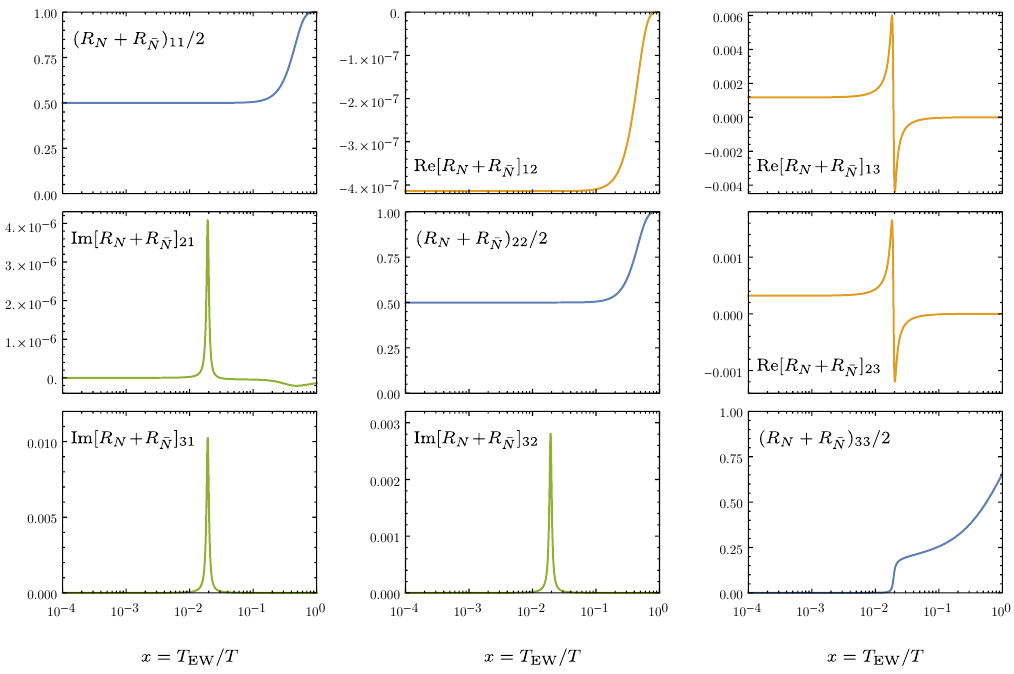
Figure 5 . Entries of the density matrix for benchmark point I) in the basis where M M is